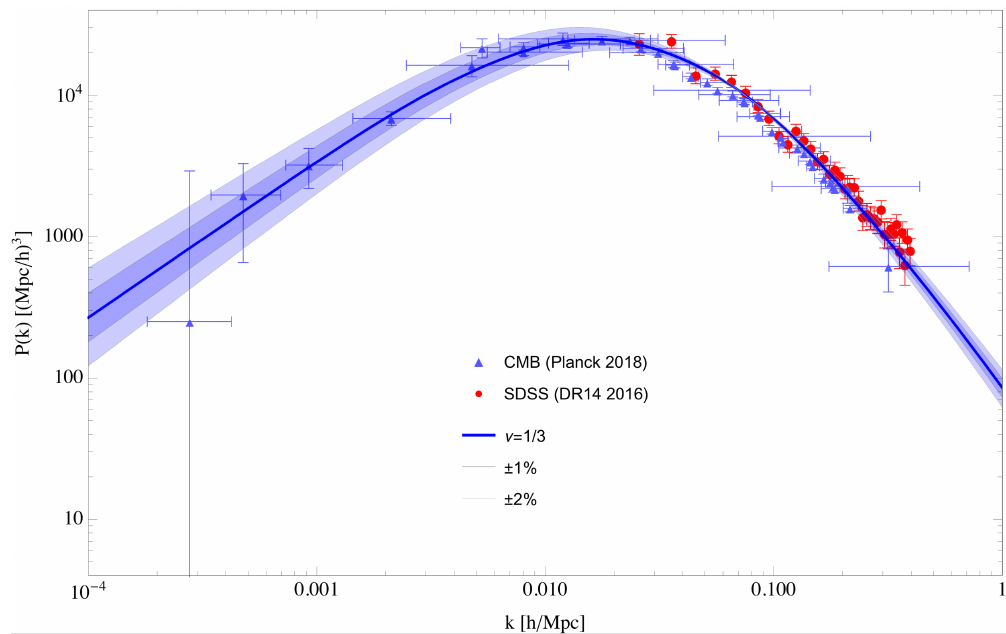
Figure 3. Matter power spectrum P ( k ) with various choices for the scaling exponent ν . The middle (blue) curve shows the matter power spectrum as predicted by quantum gravity with a value of ν = 1/3 as before, with two bands showing variance of 1–2% in the value of ν . Notice that in order to obtain general consistency with current CMB data, ν cannot deviate by more than ∼ 2% from the theoretically predicted value of 1/3. This can be viewed as a rather stringent constraint on the value of the exponent ν arising from